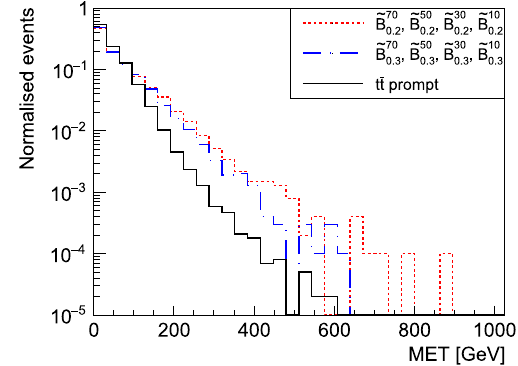
Fig. 16 Longitudinal impact parameter d z of the top quarks in the ˜ B - = 300 GeV like case with m ˜ χ 0 1